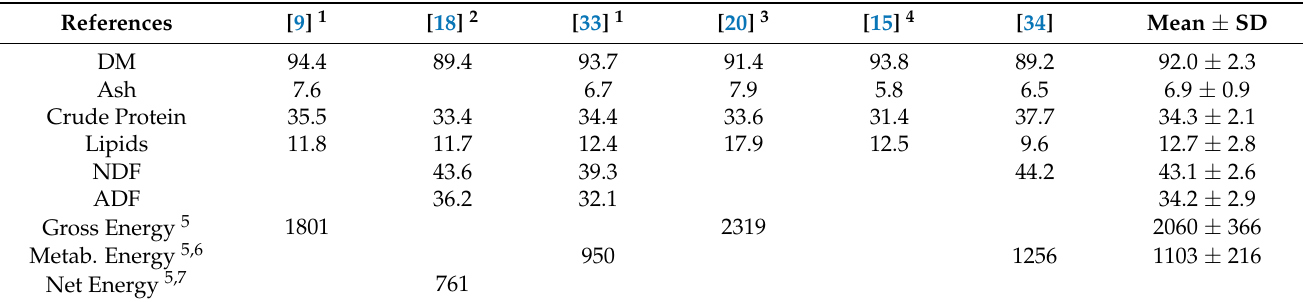
Table 2. Chemical composition (% on DM basis) of hempseed cake (obtained by cold oil pressing).